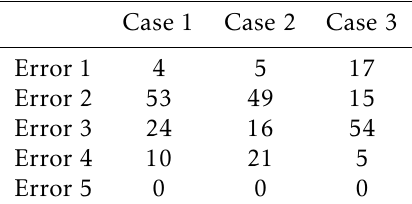
Table 2. Errors occurred in the cases of study.